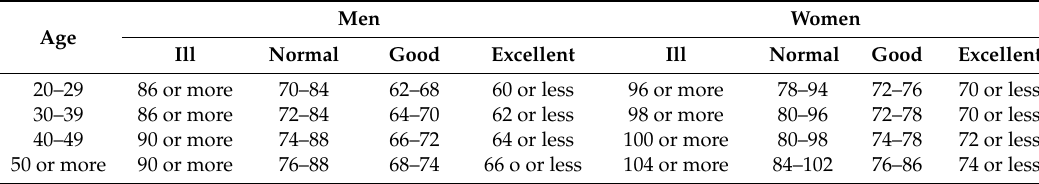
Table 1. Heart rate values based on age and